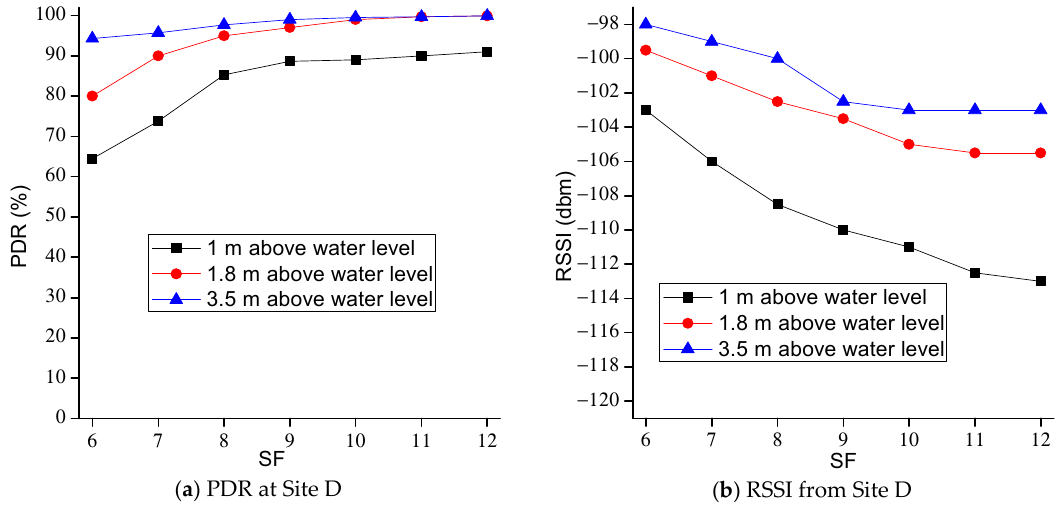
Figure 5. Performance testing at Site D.